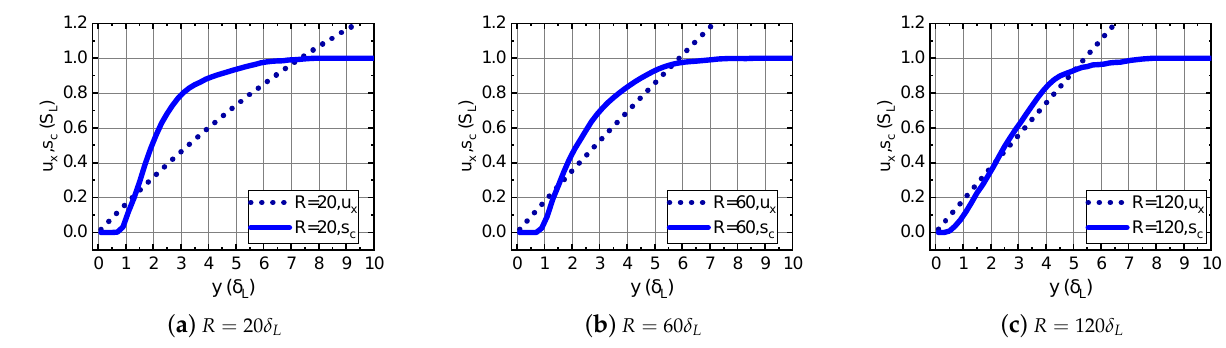
Figure 9. Comparison of the local consumption speed s c ( y ) and the incoming flow velocity u x ( y ) for R = 20,60,120 δ L (subplots ( a – c ), respectively) at the critical condition ( θ = 4).